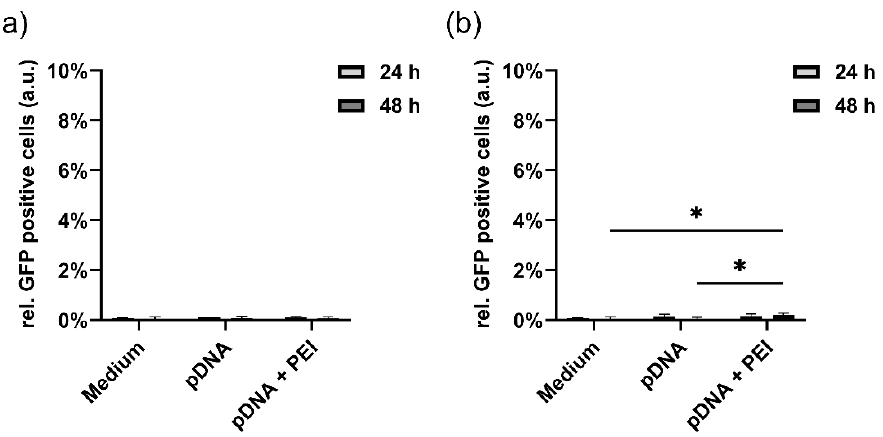
Figure A4. Transfection controls adding pure medium, pure pDNA without transfecting agent and pDNA with PEI as transfecting agent for ( a ) 5 ng pDNA and ( b ) 10 ng pDNA. No fluorescence signal was detected for any sample with 5 ng pDNA, while a slightly increased signal (0.2% ± 0.1%) could be seen for 10 ng pDNA + PEI after 48 h of incubation. Statistically significant changes were calculated with two-way ANOVA (* for p <